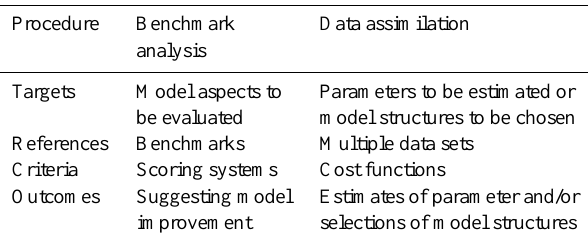
Table 5. Comparison of evaluation procedures between benchmark analysis and data